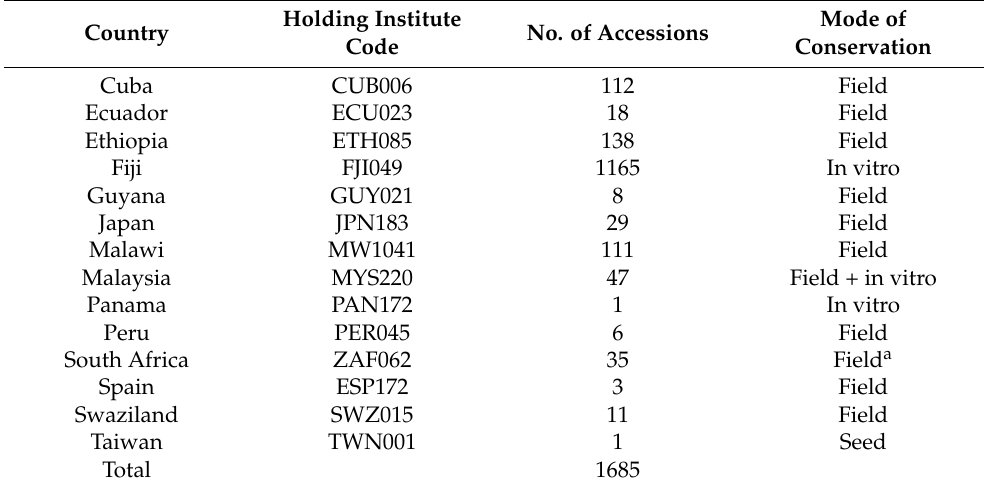
Table 1. Global taro ( Colocasia spp.) genetic resources conserved ex situ in 2017, based on the WIEWS. Holding Institute Mode of Country No. of Accessions Code Conservation Cuba CUB006 112 Field Ecuador ECU023 18 Field Ethiopia ETH085 138 Field Fiji FJI049 1165 In vitro Guyana GUY021 8 Field Japan JPN183 29 Field Malawi MW1041 111 Field Malaysia MYS220 47 Field + in vitro Panama PAN172 1 In vitro Peru PER045 6 Field South Africa ZAF062 35 Field a Spain ESP172 3 Field Swaziland SWZ015 11 Field Taiwan TWN001 1 Seed Total